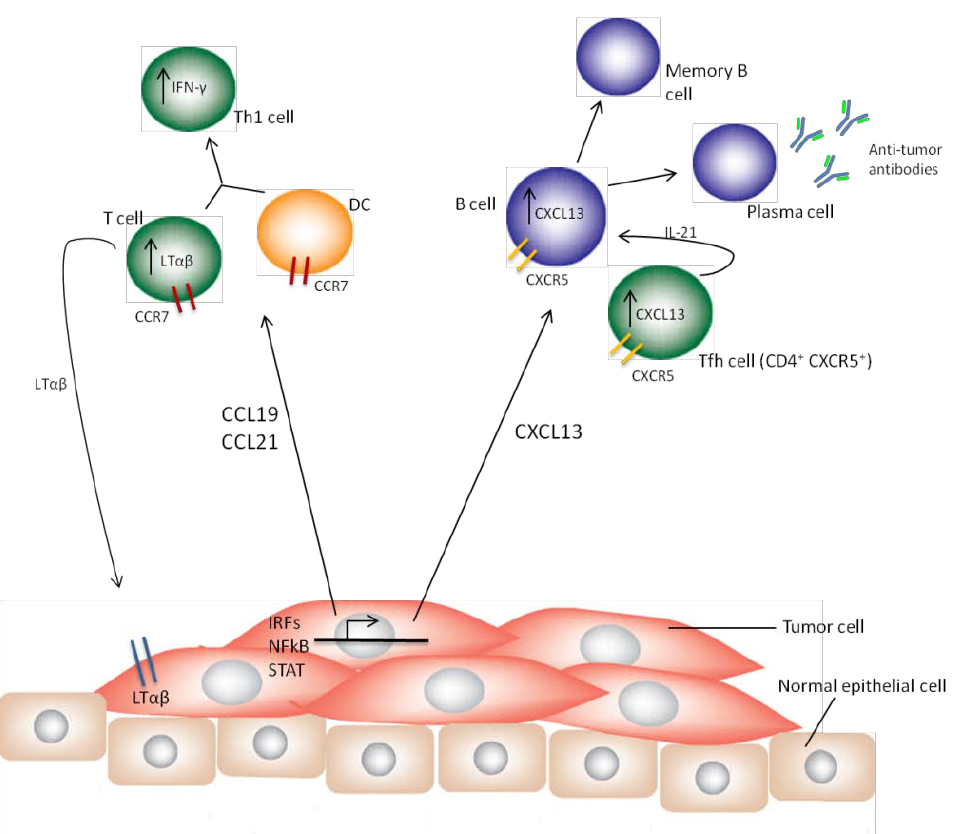
Figure 2. Working model of an IR + tumor and TLS induction. In IR + tumors, expression of transcription factors such as the interferon regulatory factors (IRFs), NF- κ B and STAT molecules regulate TLS-inducing cytokines and chemokines. Tumor secretion of CCL19 and CCL21 recruits CCR7 + DC and T cells. CCL19 and CCL21 induce LT αβ expression and secretion from T cell populations which may further stimulate inflammatory cytokine release from tumor cells via LT αβ R signaling. Tumor-derived CXCL13 recruits B cells and CD4 + CXCR5 + Tfh cells. The Tfh cells stimulate B cell differentiation and activation in part via IL-21. This promotes the development of anti-tumor memory B cells and plasma cells secreting tumor-specific antibodies. With a functional TLS in place, efficient antigen presentation, cell activation and differentiation occurs for both a humoral and cell-mediated anti-tumor immune response. In an IR- tumor, many of the regulatory transcription factors and/or their downstream chemokines are downregulated. In the absence of TLS-inducing chemokines, severe immune deficits occur allowing for tumor immune